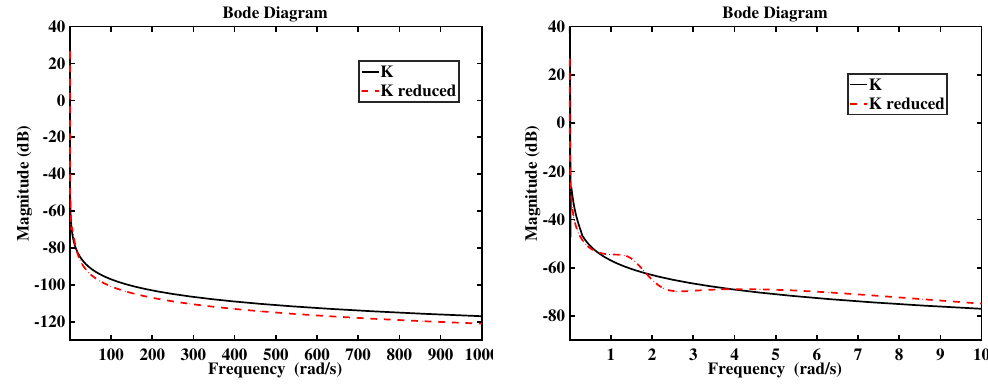
Figure 2. Bode magnitudes of the given system (solid black) and the approximation (dashed red) yielded by Problem 1. ( left ) Magnitude, ( right ) Low frequency